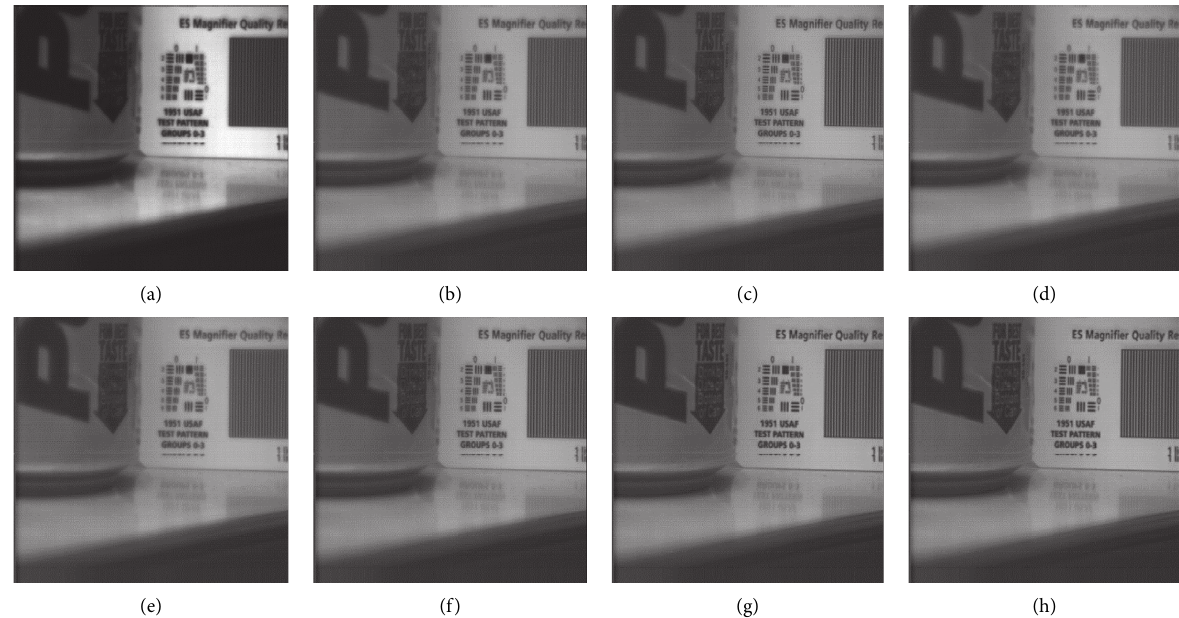
Figure 6: The fusion results of “Pepsi-Cola.” (a) PCNN. (b) Contourlet. (c) GAN. (d) Shearlet. (e) CSR. (f) SR-SML. (g) DCNN. (h) Proposed.